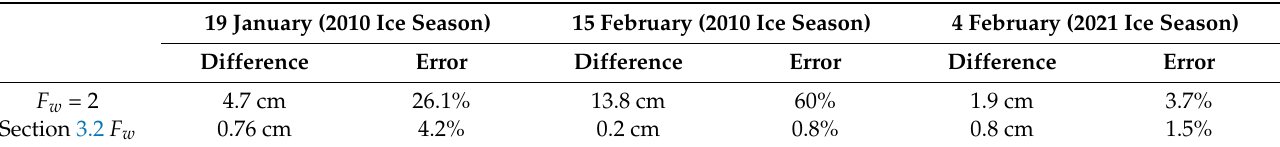
Figure 10. Simulation results under different oceanic heat fluxes (12 January–19 January in winter 2009–2010; 23 January–15 February in winter 2009–2010). Table 2. Simulation errors at different oceanic heat